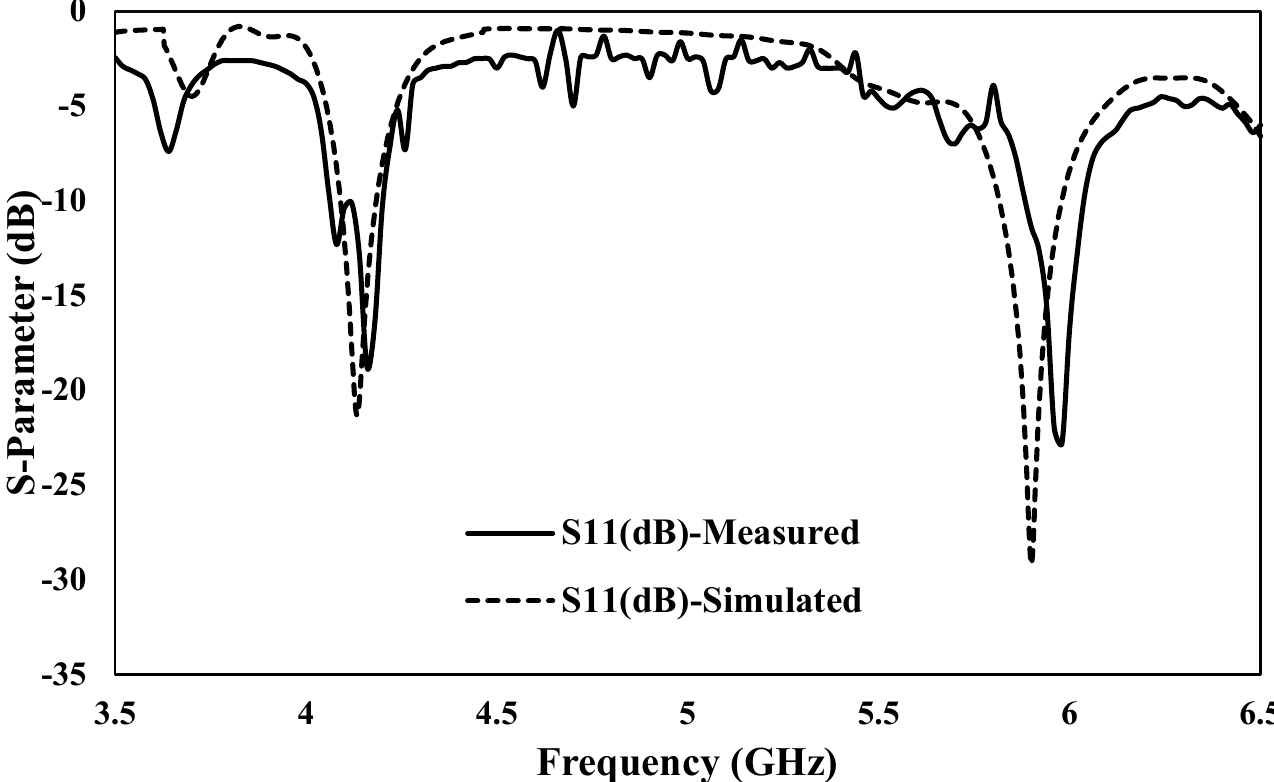
Figure 7. Shows ( a ) front view of a fabricated prototype of four-element MSFAA with dimensions, and ( b ) back view highlighting the four-element MSFAA feed network using WPDs and co-axial cables.